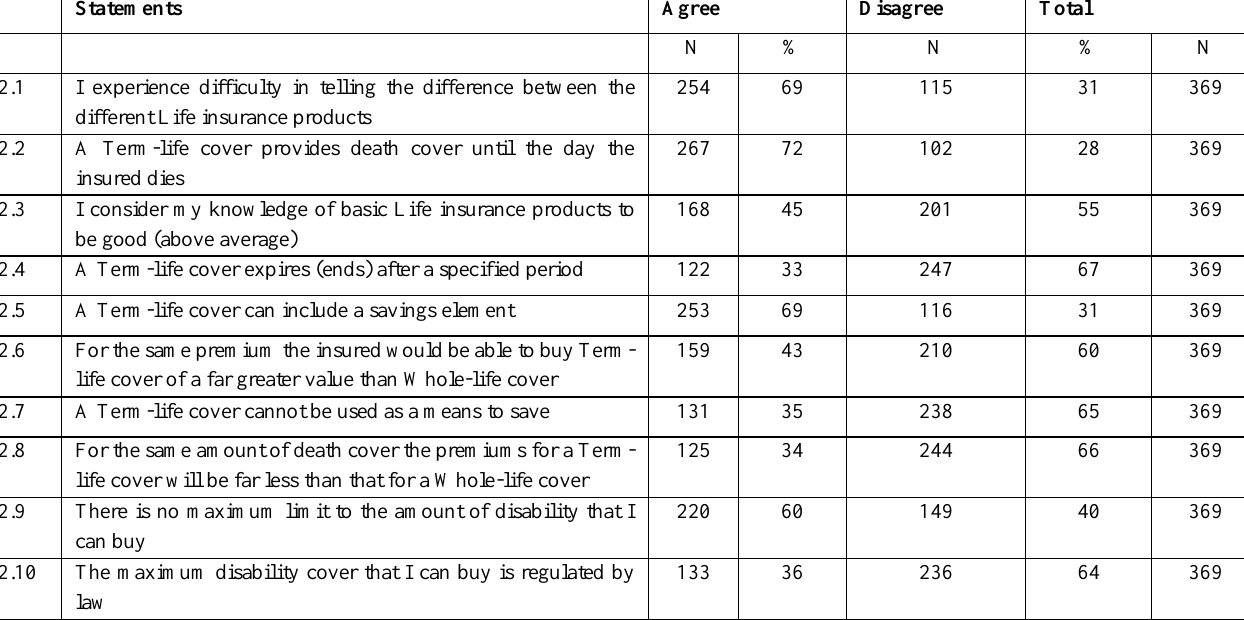
Table 2: Responses to knowledge of features of basic insurance